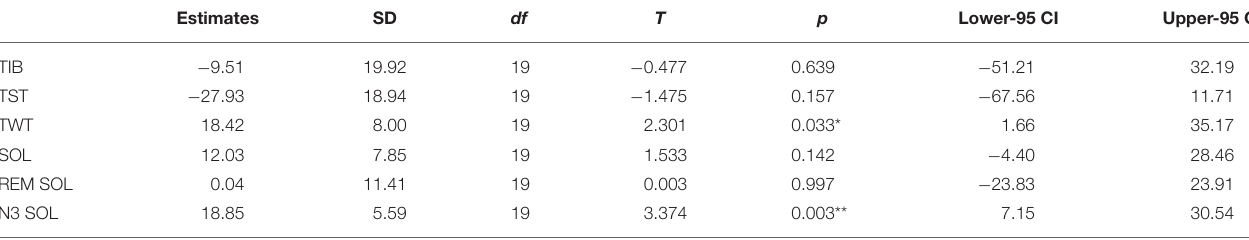
TABLE 3 | Overview of linear mixed models analysis for sleep indices (in minutes) ∼ time.